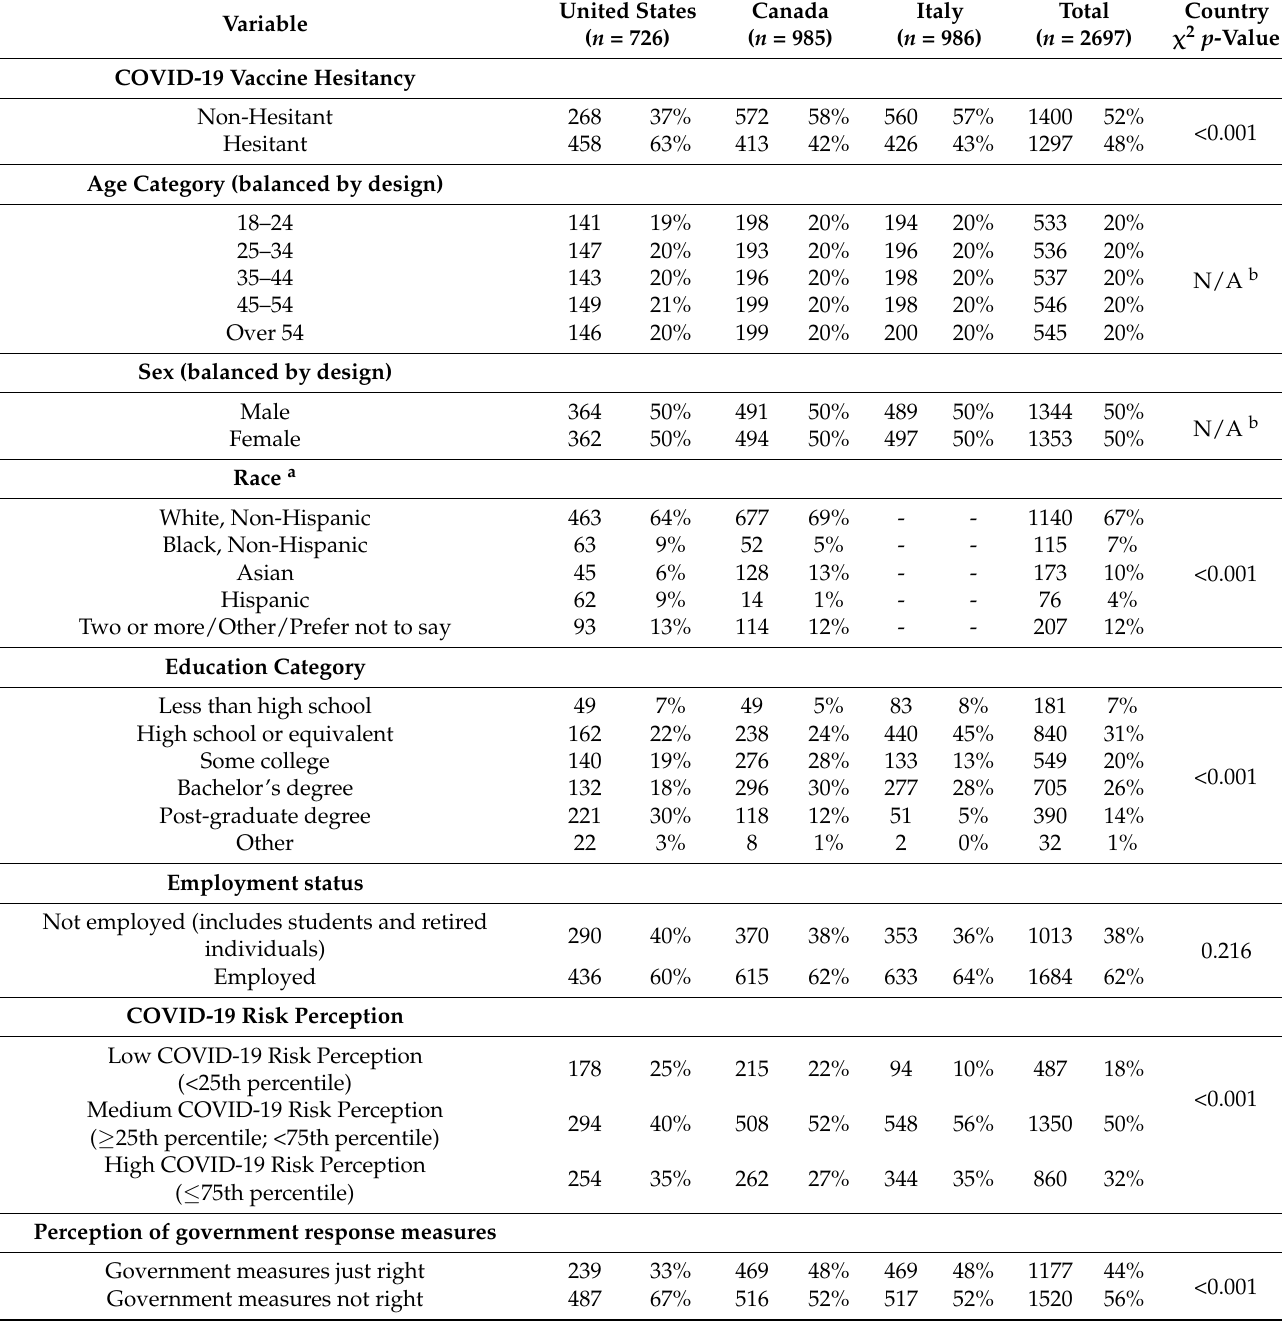
Table 1. Descriptive Statistics (Overall and by